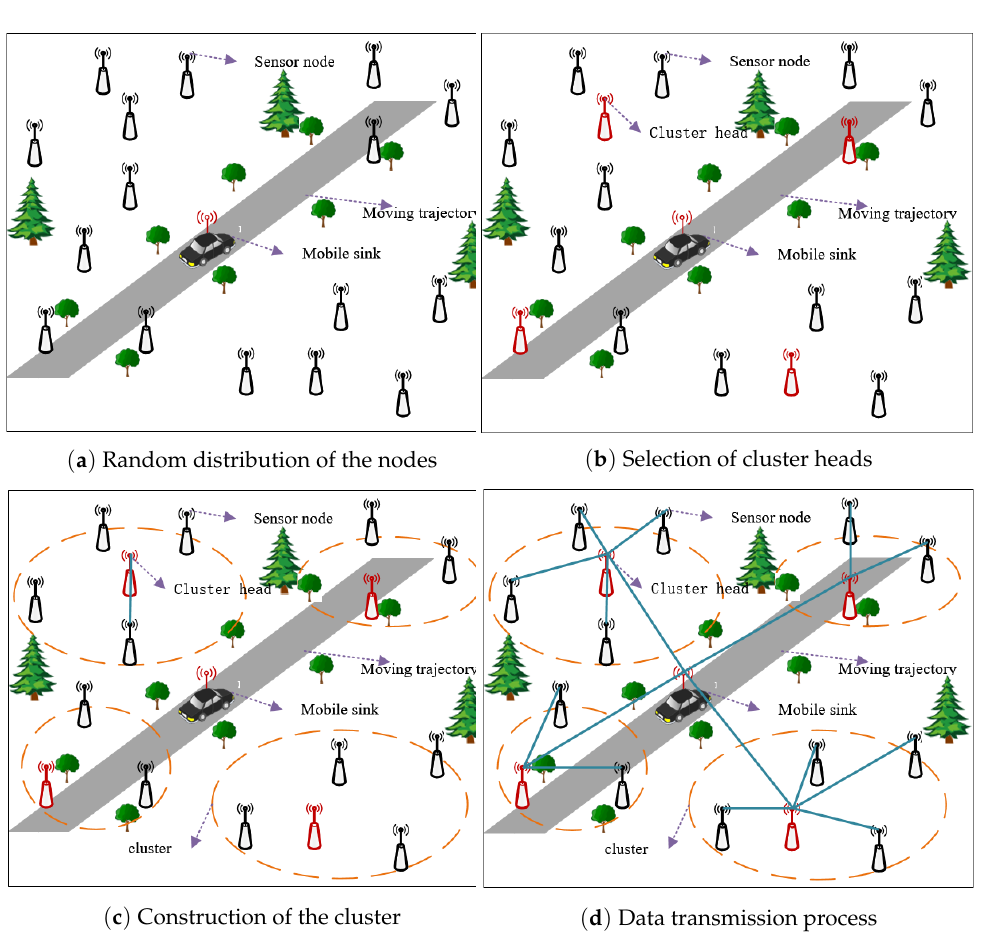
Figure 7. Cluster construction and data